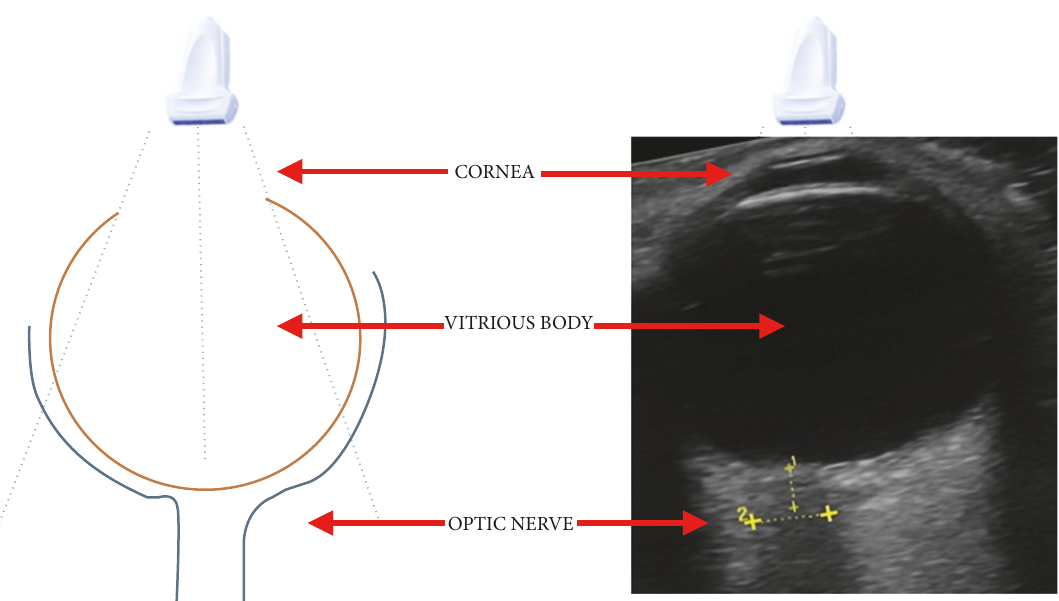
Figure 2: Representation of the anatomy under ultrasound vision.